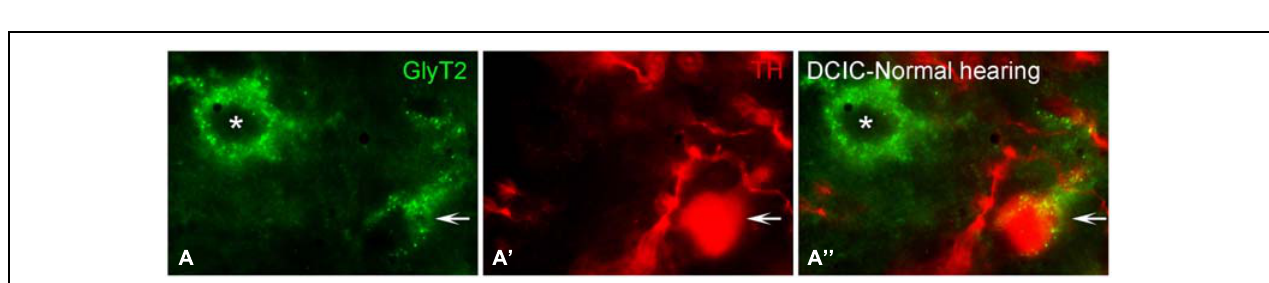
FIGURE 11 | In the IC GAD67 (green) is distributed throughout each subdivision and is closely associated with TH labeled (red) en passant terminals. Terminals labeled for GAD67 in the central nucleus (CNIC), external cortex (ECIC), and dorsal cortex (DCIC) of